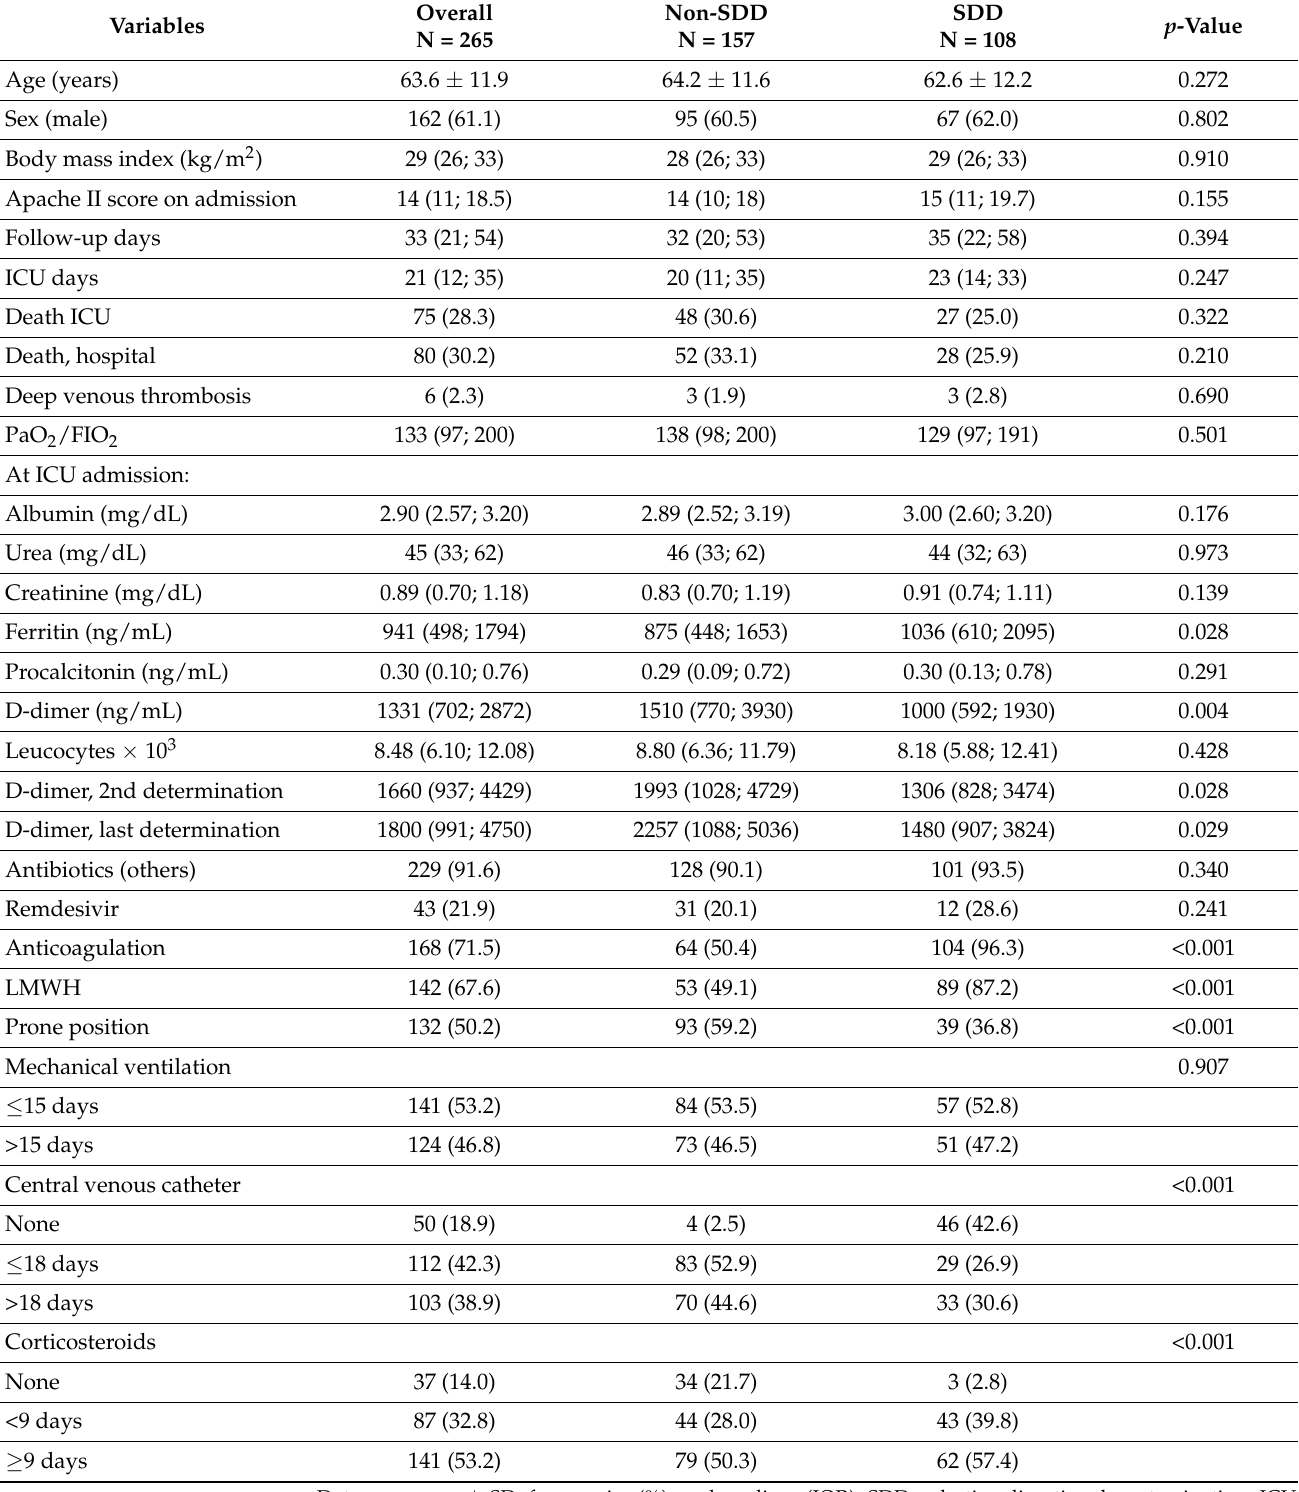
Table 1. Characteristics of the patients according to the SDD